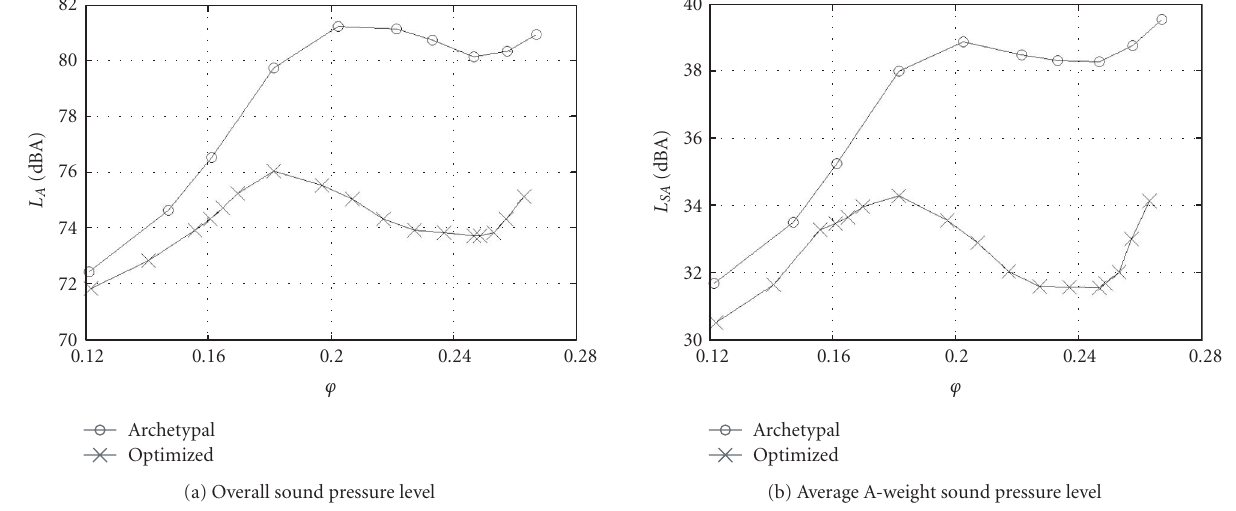
Figure 11: Aerodynamic performance